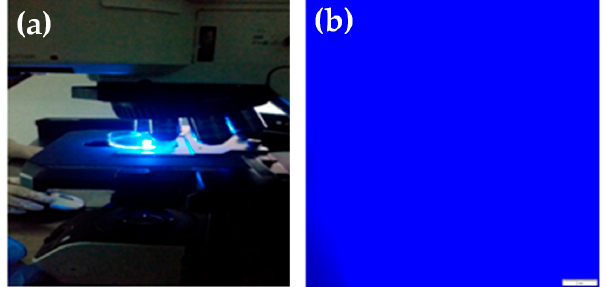
Polymers 2016 , 8 , 411 6 of 13 Figure 2. ( a ) Photograph of the BIEE/pDMAEMA/pAnMMA semi-interpenetrating network (semi-IPN) polymer network when exposed to UV irradiation, displaying strong blue emission; ( b ) corresponding fluorescence microscopy image. The scale bar in Figure 2b is 100 µ m.